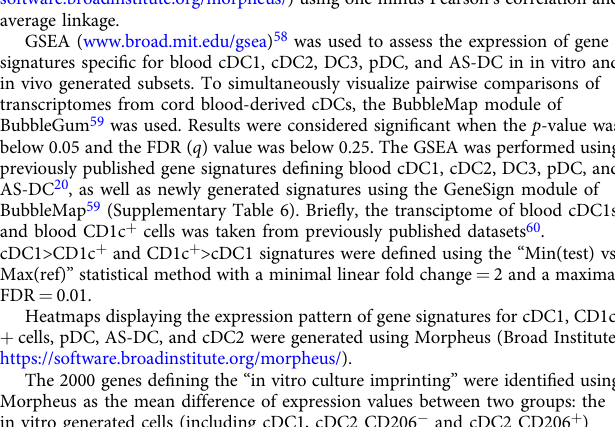
Fig. 8 In vitro and in vivo cDC2 functionally align to blood cDC2. a Histograms showing upregulation of activation markers HLA-DR, CD86 and CD83 in in vitro-differentiated cDC2 in response to TLR4 (LPS) and TLR8 (VTX-2337) overnight (16 h) stimulation. b Representative FACS plots and quanti fi